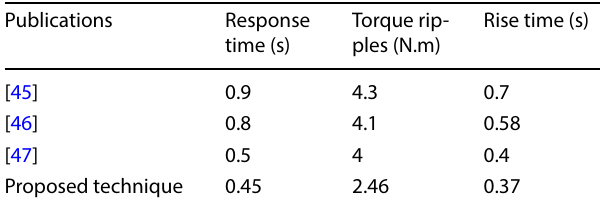
Table 8 Comparison between the proposed technique and other methods used for